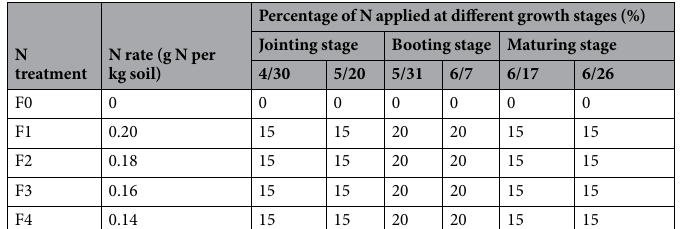
where ET is crop evapotranspiration, I is total irrigation water over the growth season (liters), θ h is soil water reserved at the harvest stage (liters), θ 0 is soil water content at the beginning of the experiment. During the whole experiment, there was no leakage and runoff. Water use efficiency on the basis of total dry mass (WUEt) or dry seed yield (WUEs) was calculated, respectively,